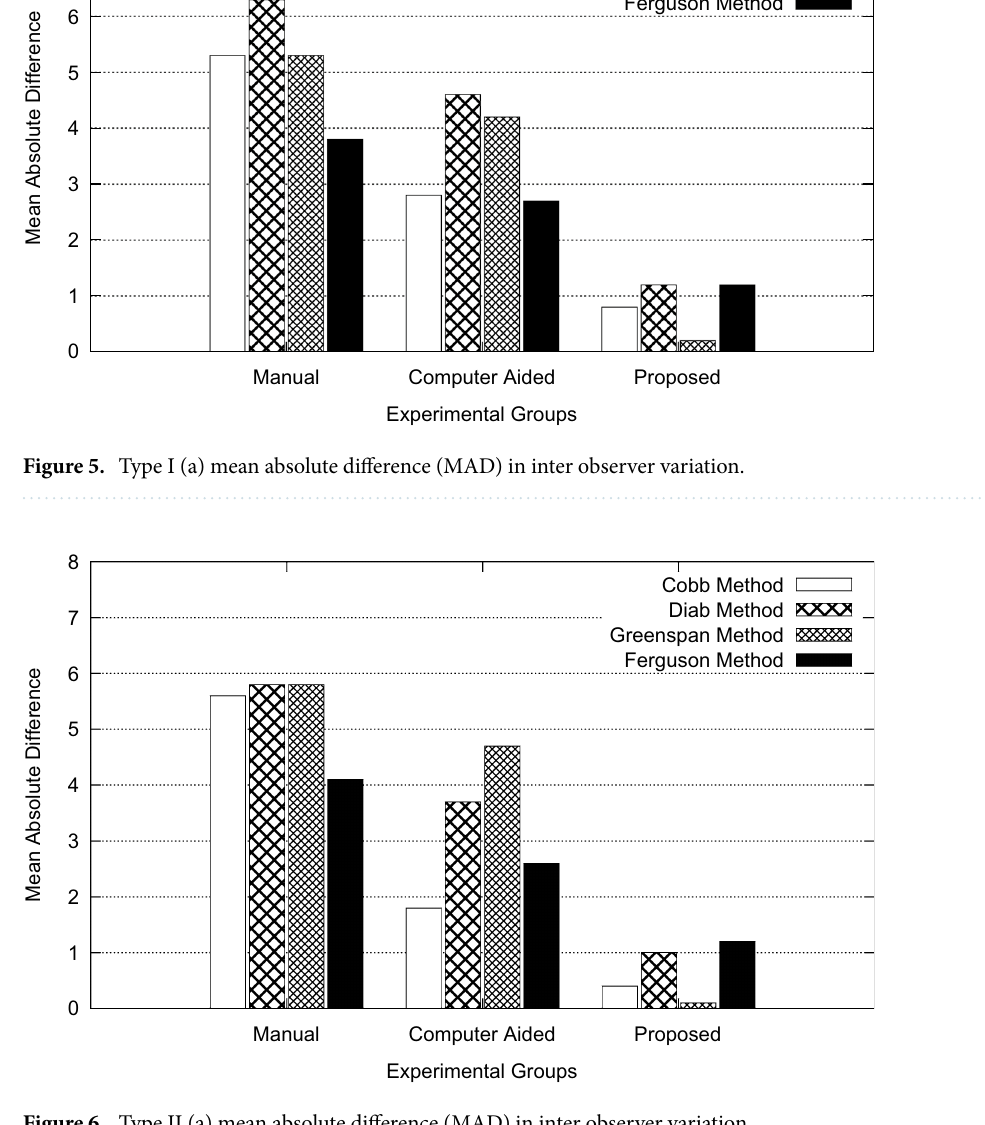
Figure 6. Type II (a) mean absolute difference (MAD) in inter observer